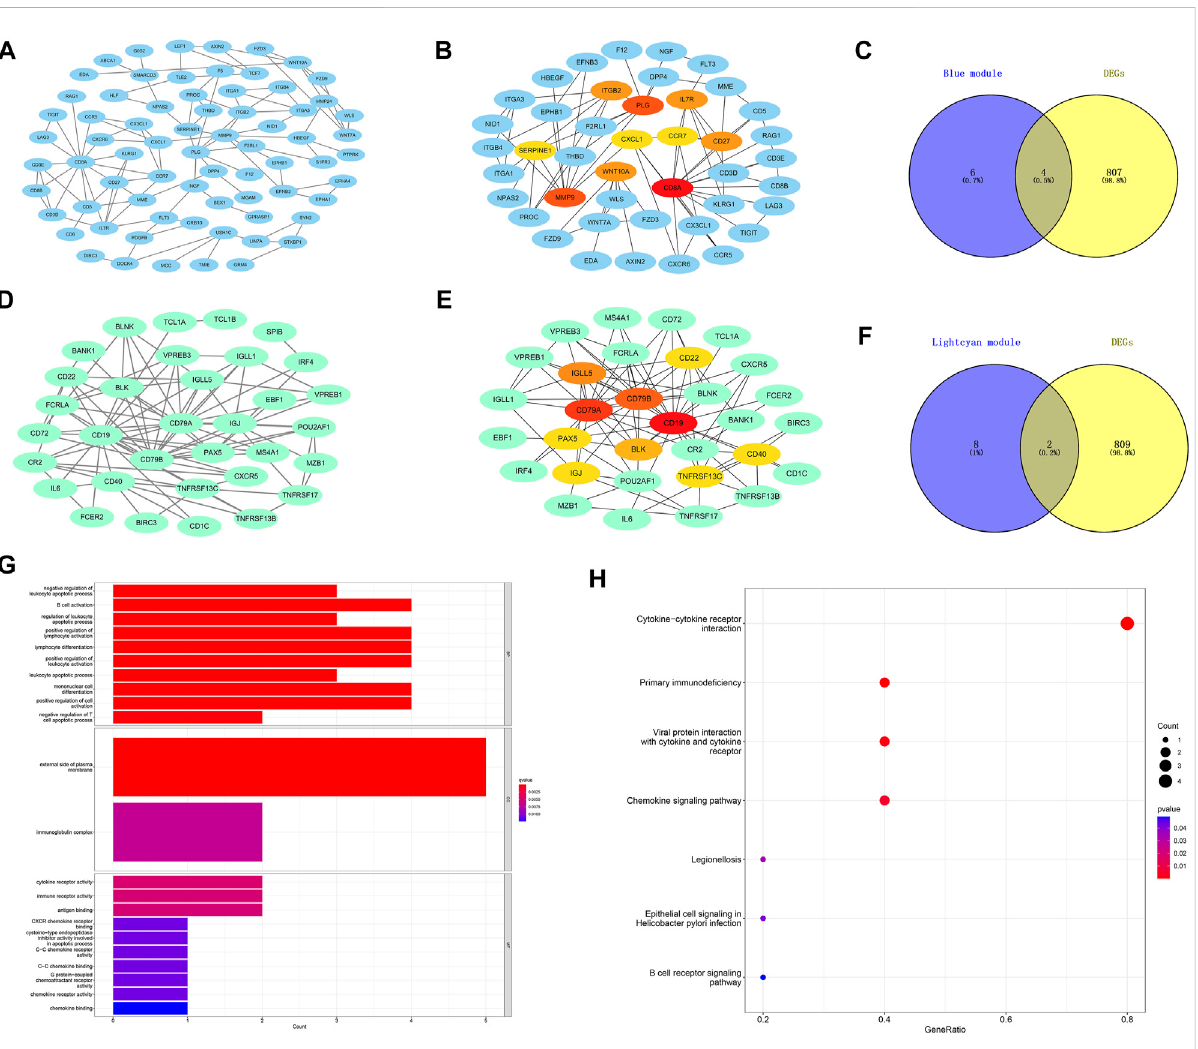
FIGURE 6 Constructionofprotein – proteininteractionnetworkswithgenes inthekeymodules and functionalenrichmentanalysis of the fi nal hubgenes. (A) Protein – protein interaction (PPI) networks associated with genes in the blue module. (B) Core gene clusters in co-expression networks of the blue module (10 hub genes). (D) PPI networks associated with genes in the light cyan module. (E) Core gene clusters in co-expression networks of the light cyan module (10 hub genes). (C,F) Blue and light cyan modules with the Venn diagrams of DEGs, a total of six fi nal hub genes. (G) GO enrichment analysis of the fi nal hub genes. (H) KEGG enriched the regulatory pathways of the fi nal hub genes. Gene ratio, the proportion of genes enriched in this term among all genes